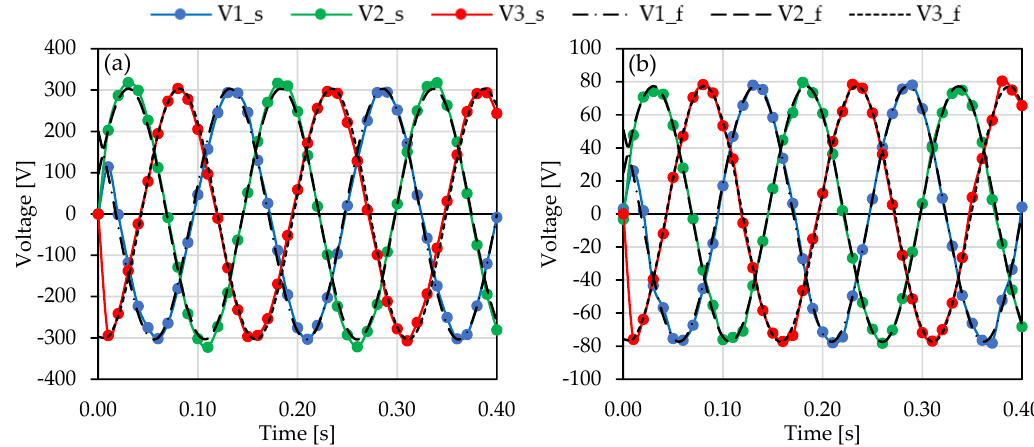
Figure 13. Comparison of no-load voltages, considering a different scheme of connection. ( a ) iron-core stator, ( b ) air-core stator.